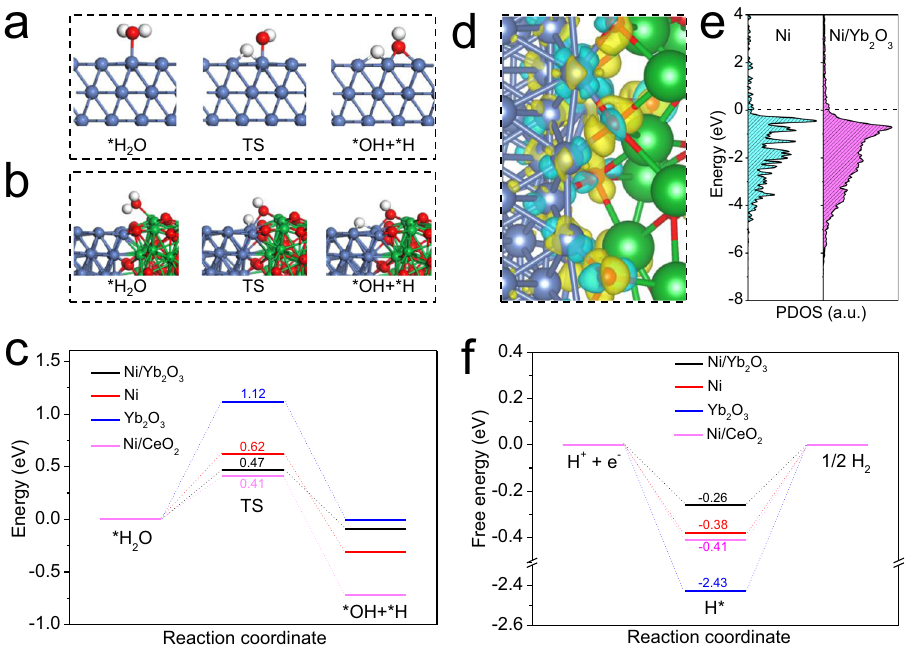
Fig. 6 Theoretical simulations. a Atomic con fi gurations of simulated H 2 O dissociation process on the optimized sites of pristine Ni(111) surface. b Atomic con fi gurations of simulated water dissociation process on the optimized sites of Ni(111)/Yb 2 O 3 (222) interface. c Kinetic barrier of water dissociation on Ni(111)/Yb 2 O 3 (222), Ni(111), Yb 2 O 3 (222) and Ni(111)/CeO 2 (111). d Difference of charge density for Ni(111)/Yb 2 O 3 (222) with the isosurface = 0.004 e bohr − 3 (yellow and cyan shadows show electron accumulation and electron depletion, respectively). e Partial density of states (PDOS) of Ni in pristine Ni and Ni/Yb 2 O 3 . f Calculated Δ G H* for Ni(111)/Yb 2 O 3 (222), Ni(111), Yb 2 O 3 (222), and Ni(111)/CeO 2 (111) systems. The blue, red, white, and green spheres represent the Ni, O, H, and Yb atoms,